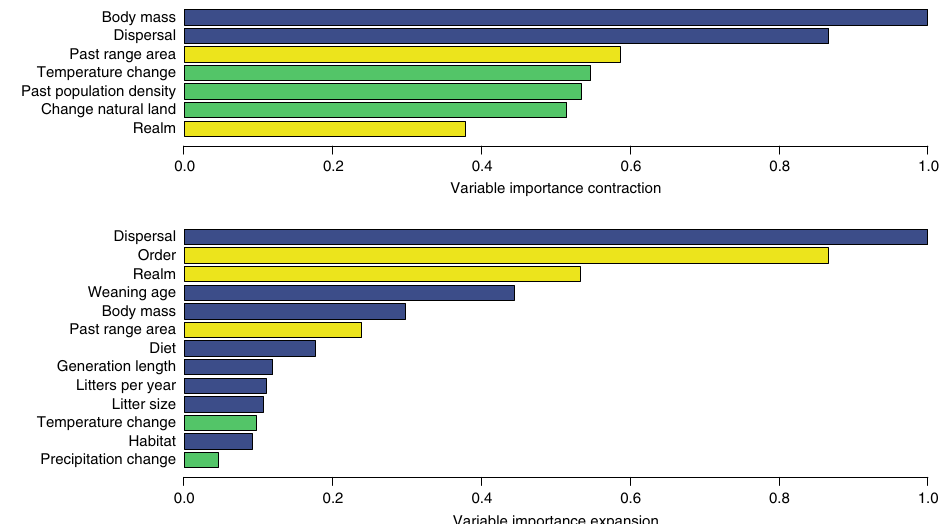
Fig. 2 Random forest variable importance plots for selected predictors in the range contraction and expansion models. The plot shows the decreasing importance of intrinsic and extrinsic variables at 10-km resolution in predicting proportional loss (upper panel) and gains (lower panel) in species ’ ranges. Big changes in these measures indicate important variables. Yellow bars indicate life-history traits, blue bars human-pressure variables and red bars other variables. n = 204 species have been